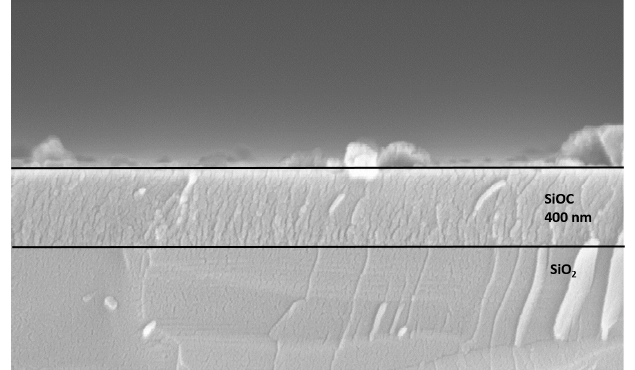
Figure 3. SEM cross-section image of SiOC deposited layer on SiO 2 /Si wafer.